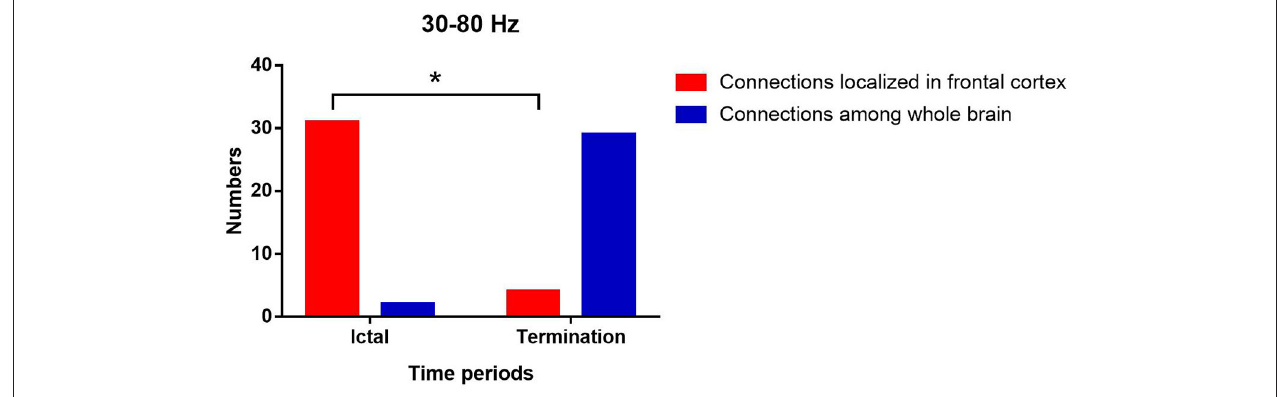
FIGURE 3 | Changes in the number of network patterns localized in frontal cortex in the two periods at 30–80Hz. P * < 0.05 after FDR and Bonferroni